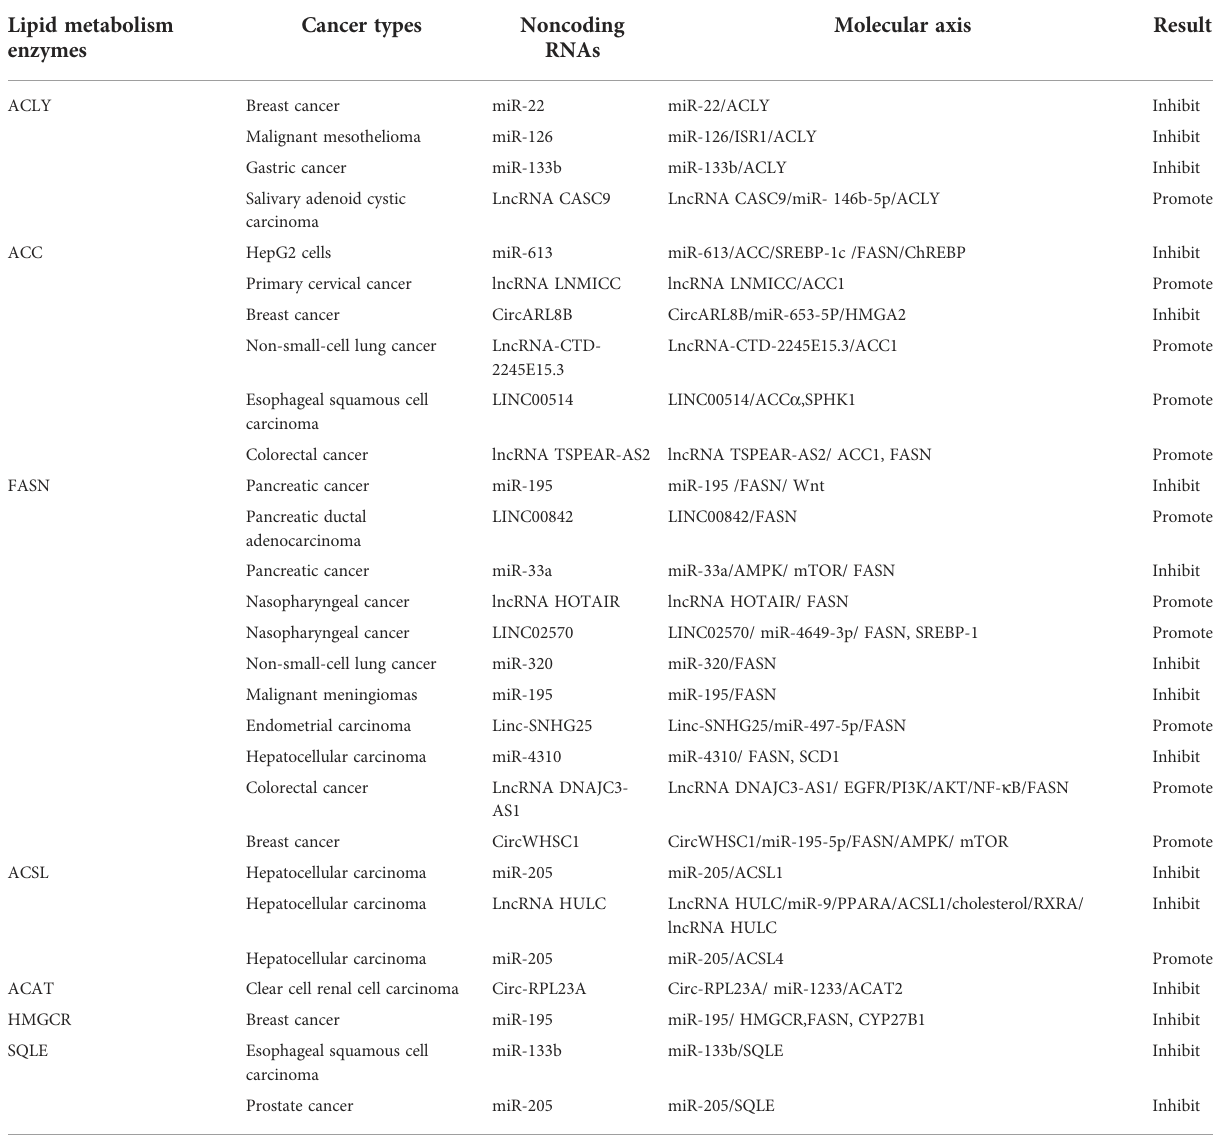
TABLE 2 Direct signaling pathways of Noncoding RNAs in tumor lipid metabolism.